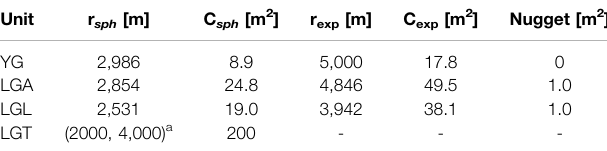
TABLE 1 | Covariance model parameters (C: contribution and r: range) used for the surface interpolation of each surface. All models are isotropic, except the LGT one with an orientation of N-S for the major axis). No covariance model was fi ttedforSUPasitssurfaceisde fi nedbytheDEM.Subscripts exp and sph indicate exponential and spherical covariance models.